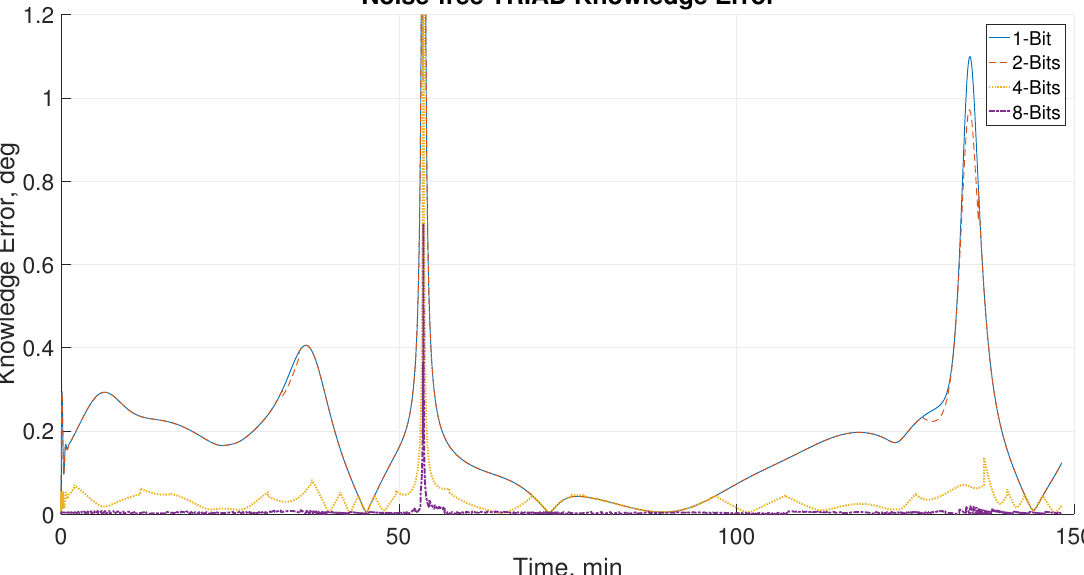
Figure 15. Close-up of knowledge error from TRIAD algorithm of 1-, 2-, 4- and 8-bit readout configurations without